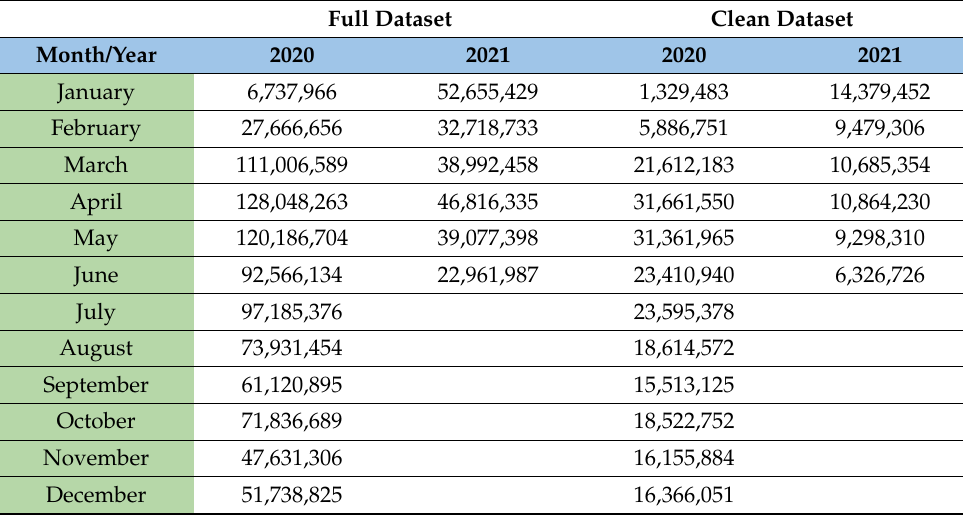
Table 1. Number of COVID-19 chatter tweets in this dataset. Full Dataset Clean